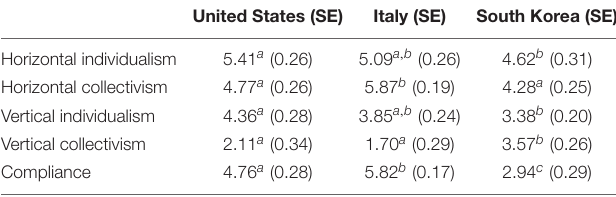
TABLE 2 | Latent means and standard errors in the structural equation